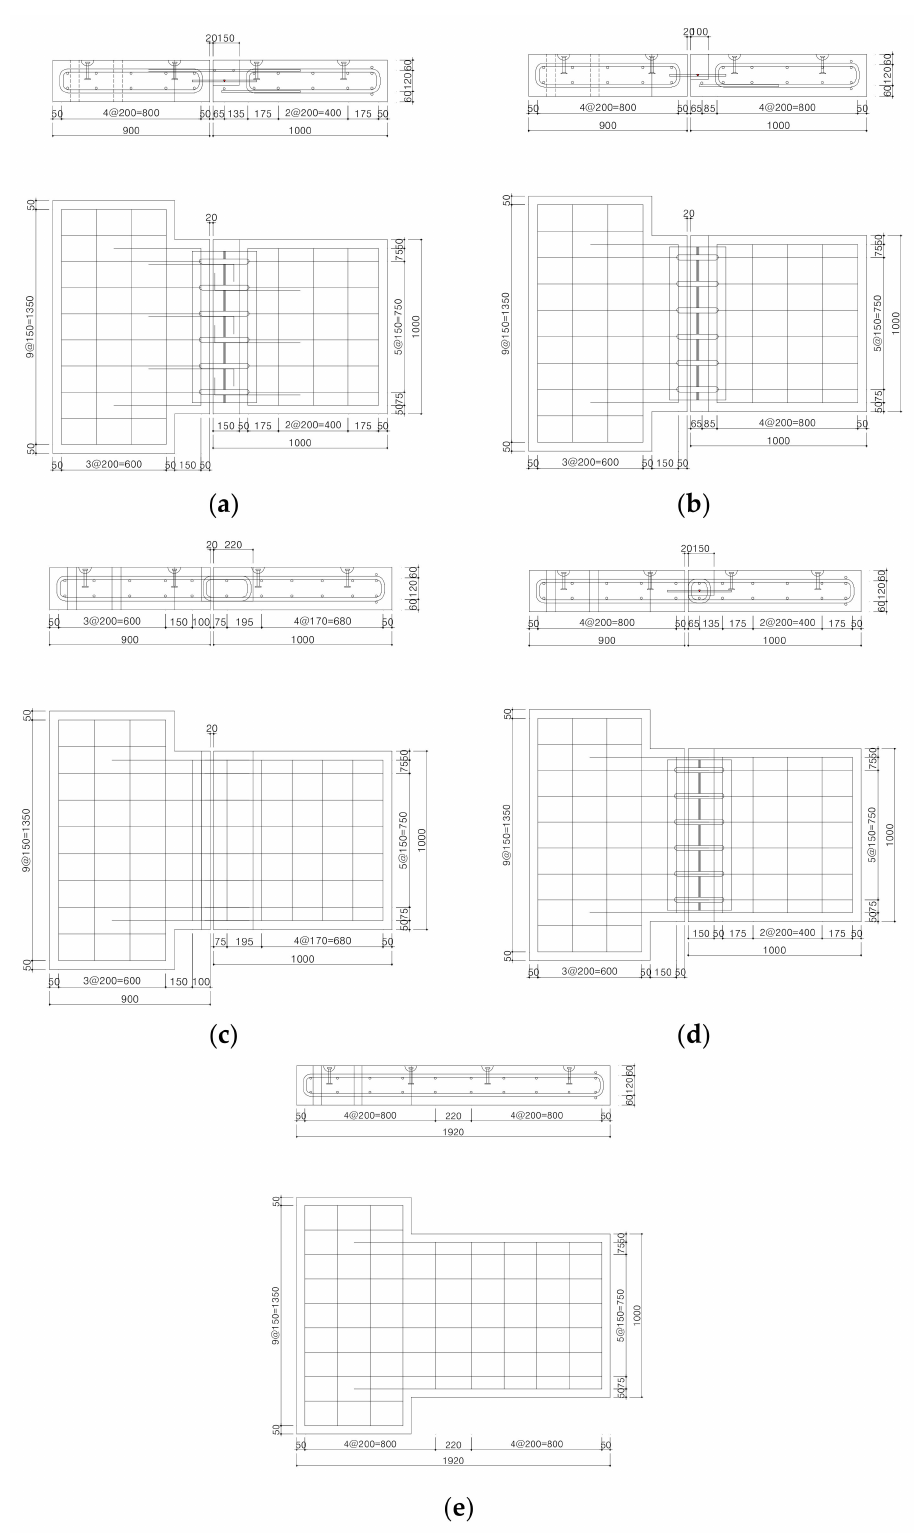
Figure 2. Details of precast bridge deck longitudinal joint specimens. ( a ) J150-HB-SP. ( b )